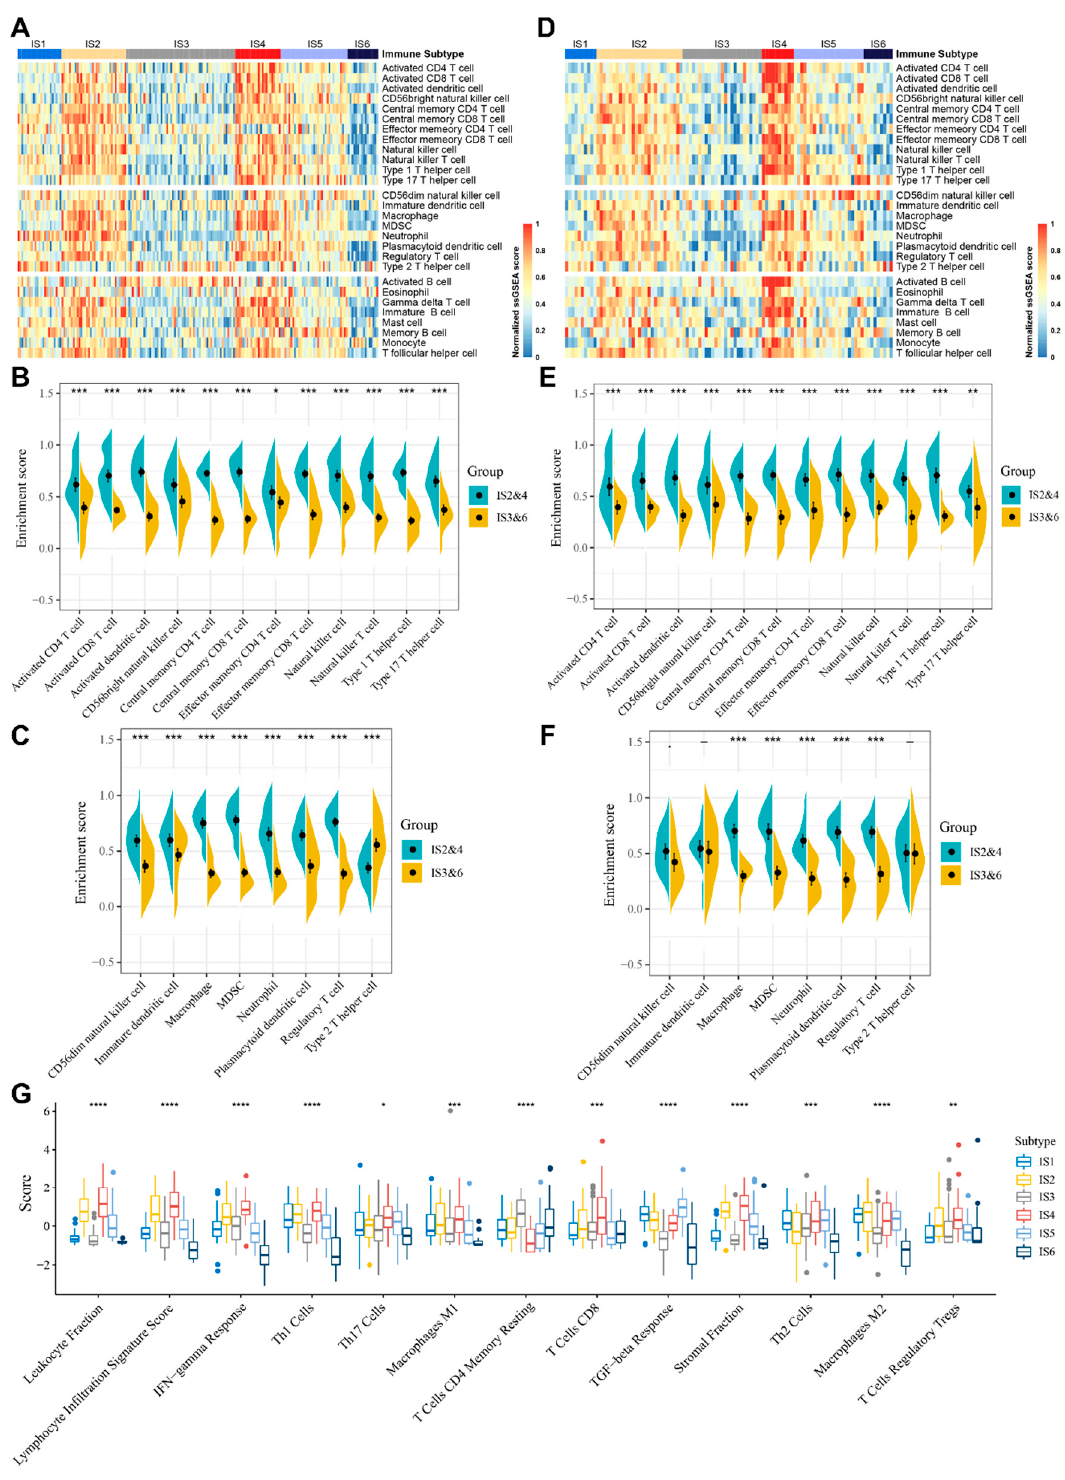
Figure 5. Cellular and molecular characteristic of immune subtypes in STS. ( A , D ) The heatmap of 28 previously reported immune cell signatures scores among STS immune subtypes in TCGA ( A ) and GEO ( D ) cohorts. ( B , C ) Differences for immunostimulatory cell ( B ) and immunosuppressive cell ( C ) signatures scores between IS2 and IS4 and IS3 and IS6 in TCGA cohort. ( E , F ) Differences for immunostimulatory cell ( E ) and immunosuppressive cell ( F ) signatures scores between IS2 and IS4 and IS3 and IS6 in GEO cohort. ( G ) Immune-related molecular signatures with significant differences among STS immune subtypes. − p ≥ 0.1, · p < 0.1, * p < 0.05, ** p < 0.01, *** p < 0.001, **** p < 0.0001.